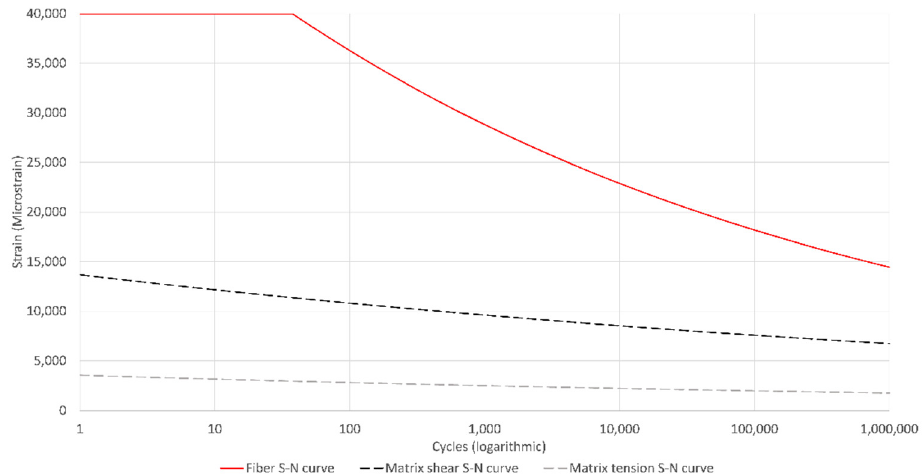
Figure 11. Three S-N curves for the fiber and the matrix directions.